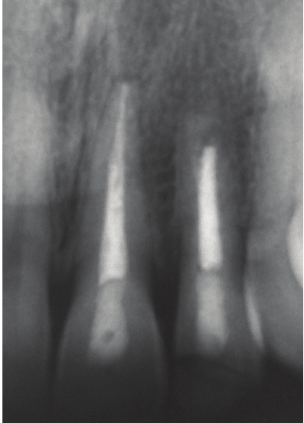
Figure 6: Radiograph of thirteen-year follow-up (March 2012).